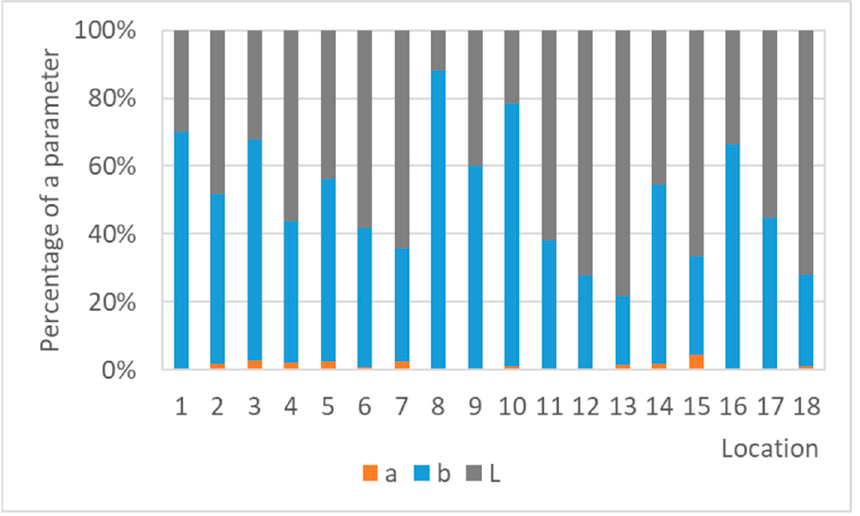
Figure 18. Percentage of the color parameters in the total color difference of silver coupons exposed for a year.